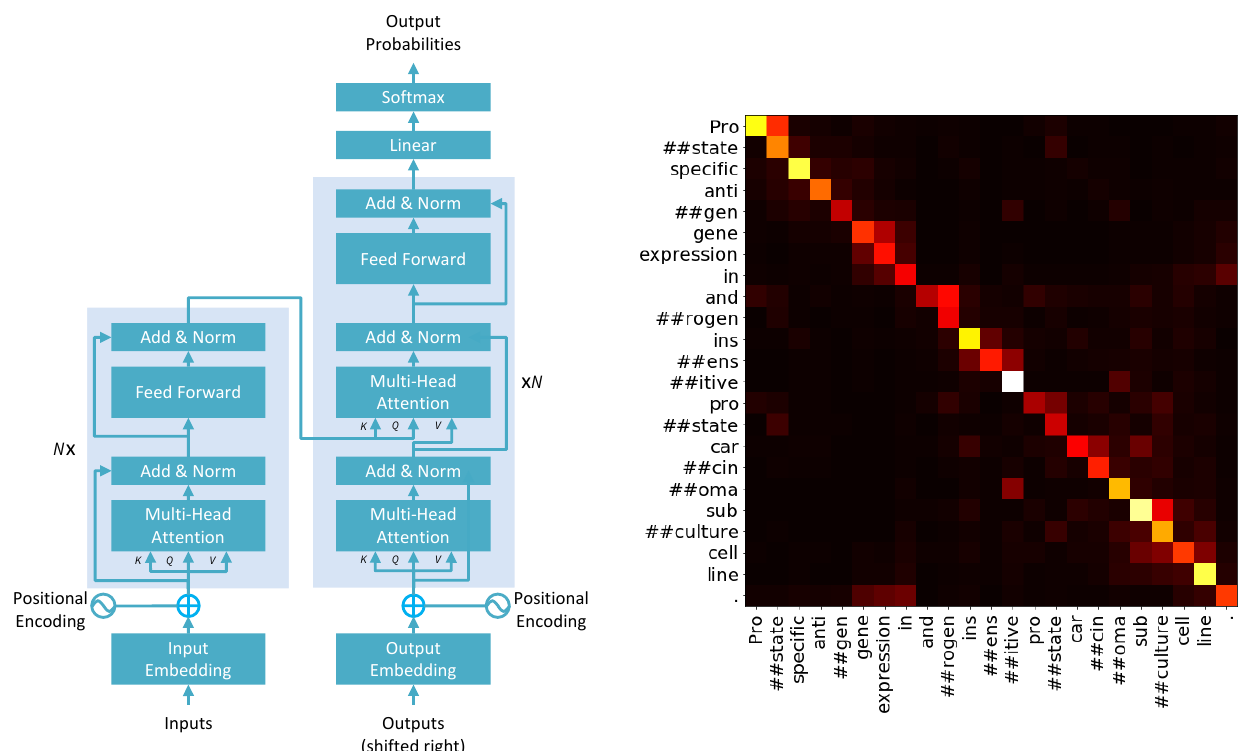
Figure 3. Left: A schematic of the transformer model architecture with attention-based encoder–decoder architecture. The encoder’s output is passed into the decoder to be used as the key and query for the second attention layer. The symbol N × next to the transformer blocks in the encoder and the decoder represents N layers of the transformer block. Right: An example heat map of the attention mechanism. The heat map shows pairwise attention weights between pieces of strings in a sentence for a trained model. A hotter hue for a block in the heat map corresponds to higher attention between the string in the row and the string in the column, respective to the